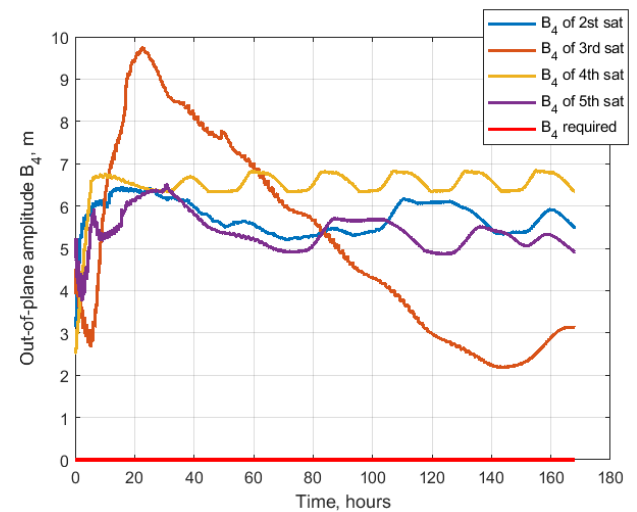
Figure 34. In-plane amplitude.